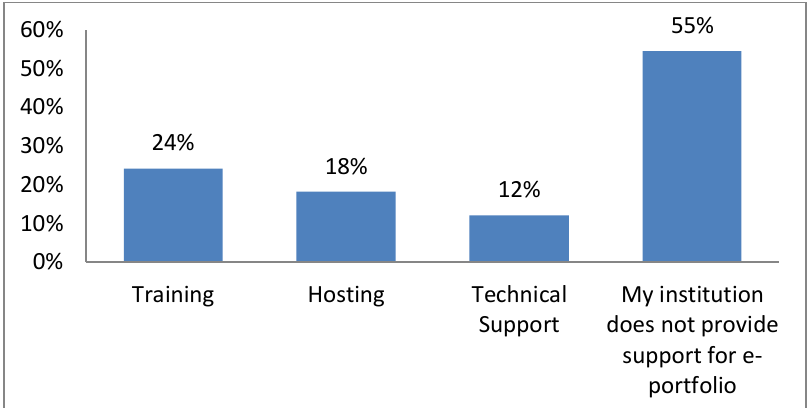
Training Hosting Technical Fig. 6 Range of supports provided by respondents’ institutions in relation to eportfolio